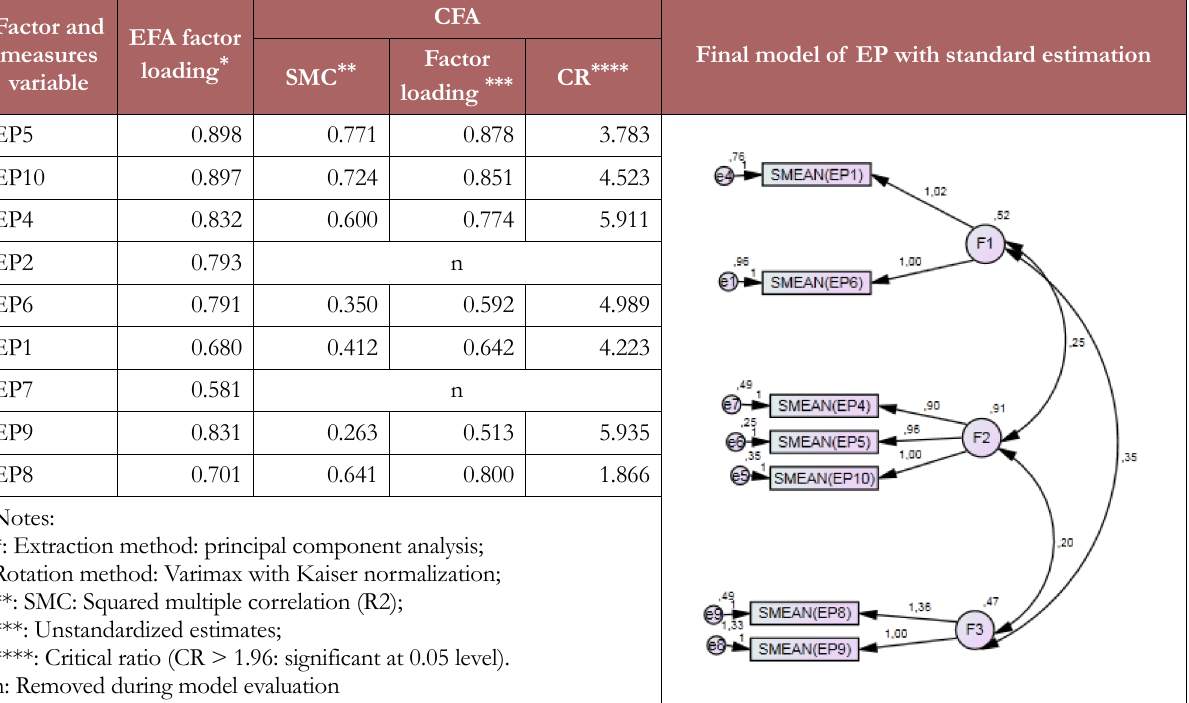
Table 14. EFA and CFA of the EP